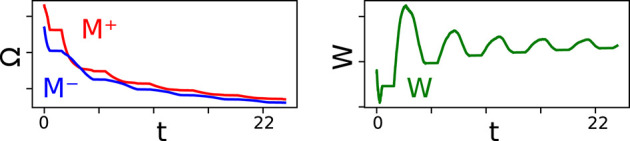
The left panel shows the evolution of the memristors' resistances in one differential synaptic pair during the learning part of the simulation. The positive memristor M+ in the pair in plotted in red, the negative memristor M− in blue. The right panel shows the corresponding network weight W whose value is given by applying Equation (2) to the resistances in the differential synaptic pair. W is unit-less and varies in the range [0, γ].